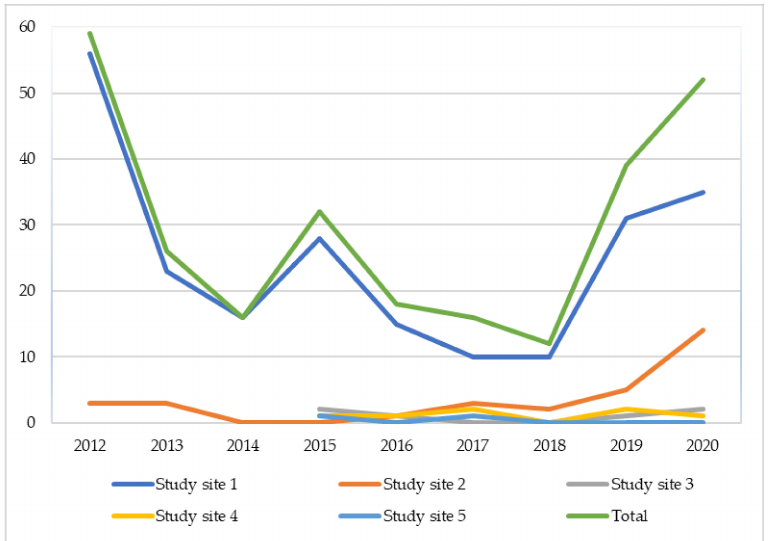
Figure 2. Counts of Dactylorhiza incarnata subsp. ochroleuca recorded over nine years in England in five study